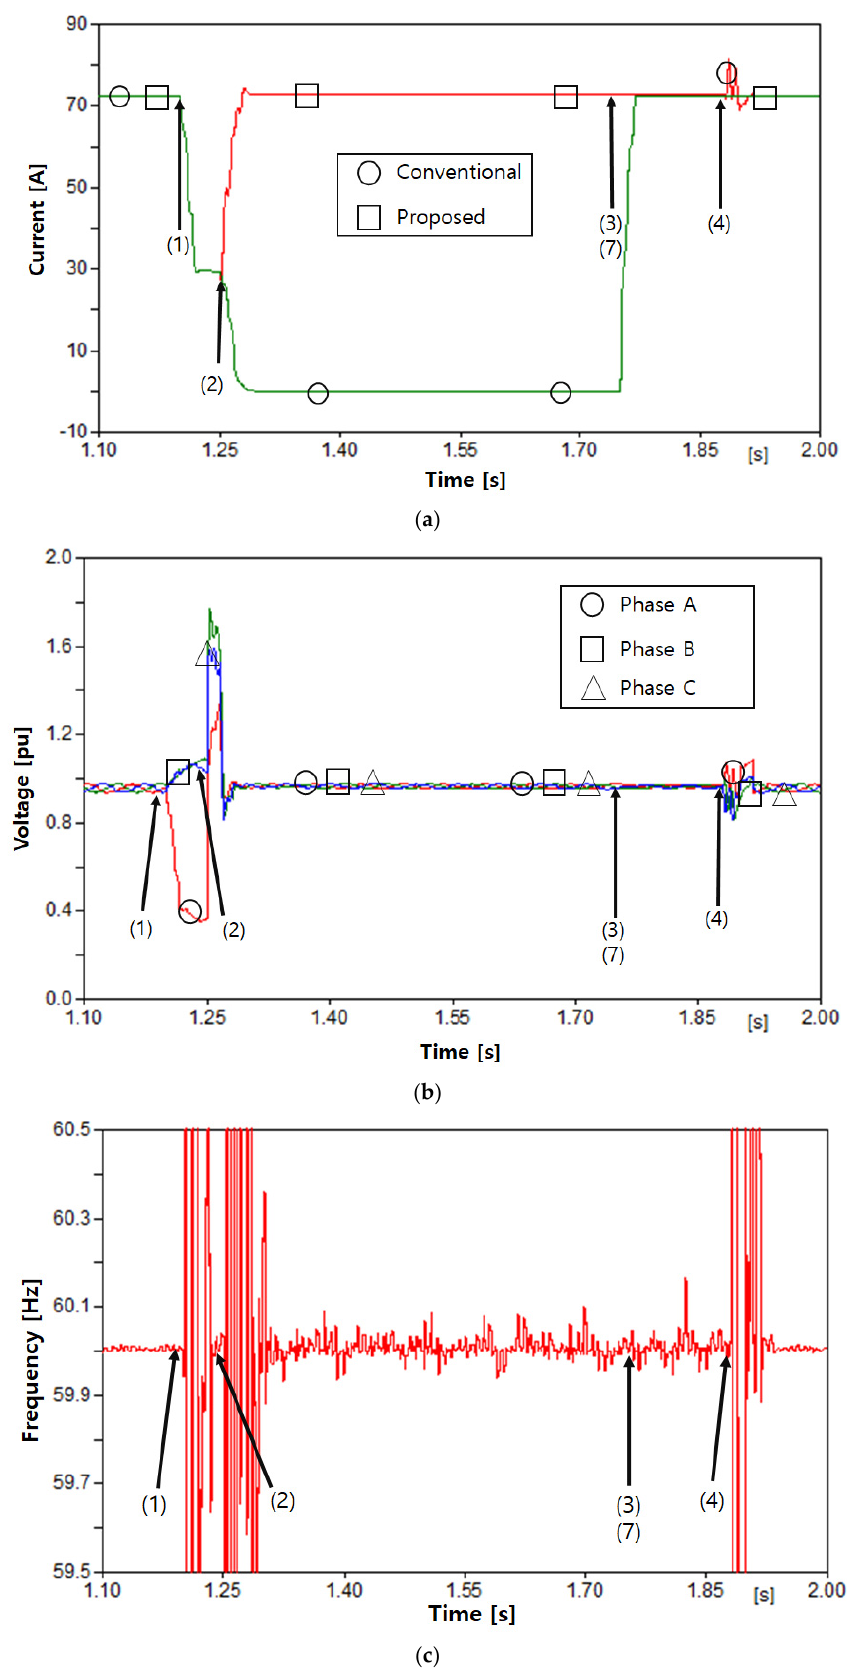
Figure 10. Simulation results of Case 3: ( a ) current flowing to Load 2; ( b ) voltage at Bus 3; ( c ) frequency at Bus 3.